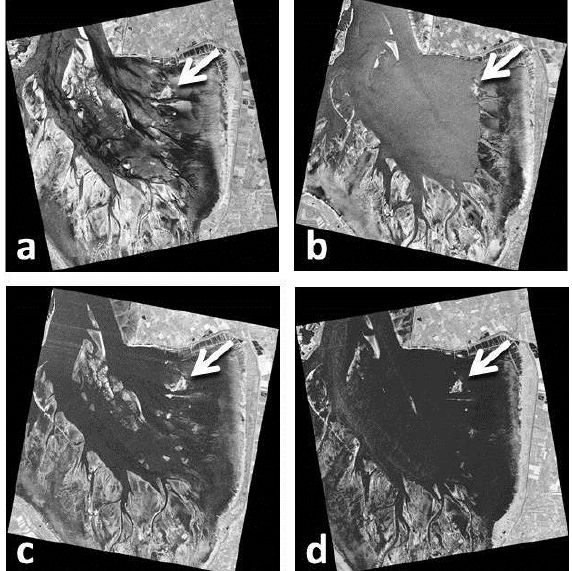
Figure 3. Test site “Jadebusen” imaged by TerraSAR-X in 2012: (a) July 3, 17:01 UTC (low tide at 17:26 UTC); (b) October 28, 05:51 UTC (04:36 UTC); (c) November 14, 05:42 UTC (05:35 UTC); (d) November 28, 17:10 UTC (17:45 UTC). The white arrows mark an extended oyster bed, which appears always brighter than its surroundings